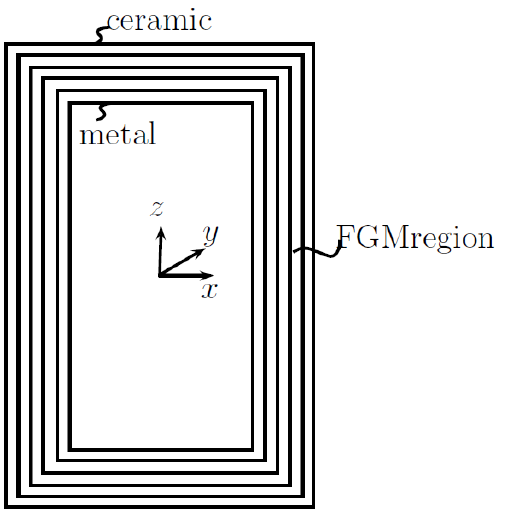
Figure 9. Thin-walled FG beam cross section.